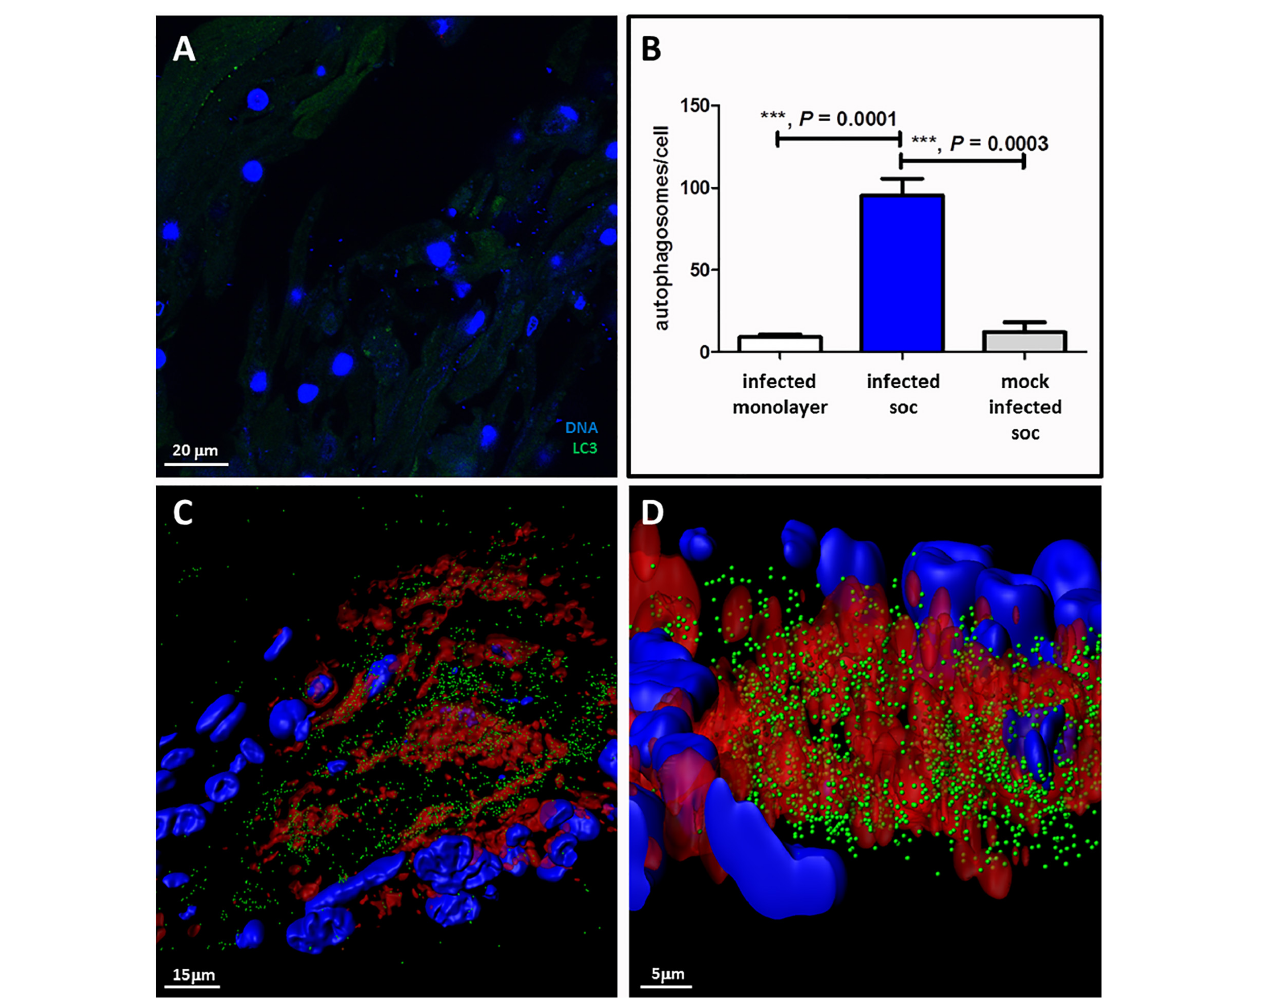
FIGURE 4 | Autophagy in VZV-infected human skin explants. (A) Autophagosome formation in mock-infected skin explants. This micrograph is representative of micrographs taken during 6 different experiments. This micrograph includes 27 nuclei in the skin. (B) Graph of the number of autophagosomes per cell in infected monolayers versus infected human SOC versus mock-infected human SOC. Data in the infected SOC bar represent 3 separate experiments; data in the uninfected SOC bar represent 6 separate experiments. (C) Enumeration of autophagosomes after rendering z-stacks of 2D images of VZV-infected SOC into 3D images by Imaris software. Top-view frame from the 3D animation shows 3740 autophagosomes (green spheres) within the cytoplasm surrounding an infectious focus when the estimated diameter within the Imaris Spot function is set at 500 nm. (D) A more enlarged side-view of the prior animation seen in panel C . VZV gE, red; LC3, green; Hoechst stain, blue. Three asterisks ∗∗∗ indicates highly significant result.